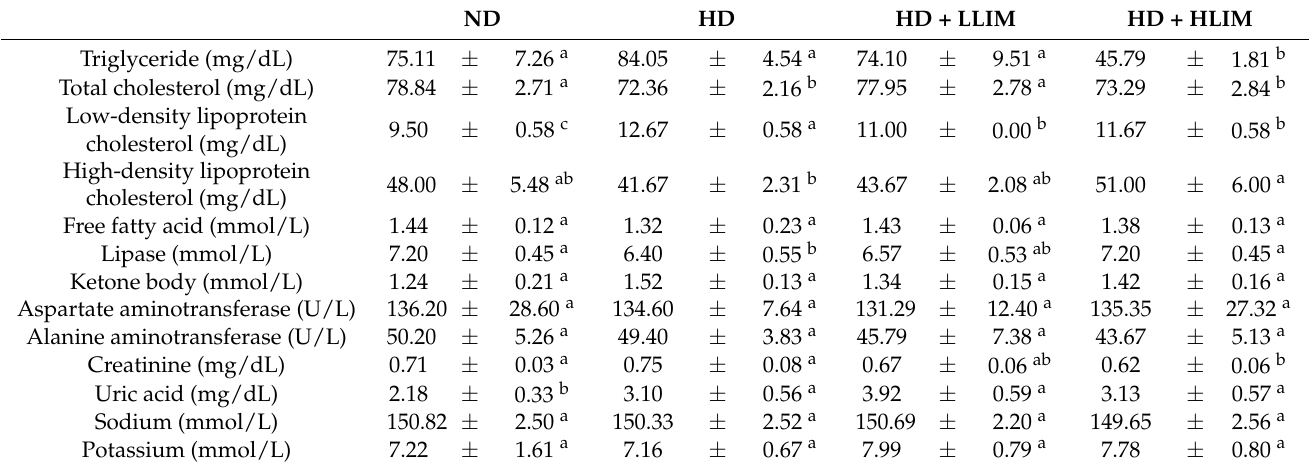
Table 2. Effect of limonene (LIM) on biochemical parameters in high-calorie diet-induced obese rats. ND HD HD + HLIM